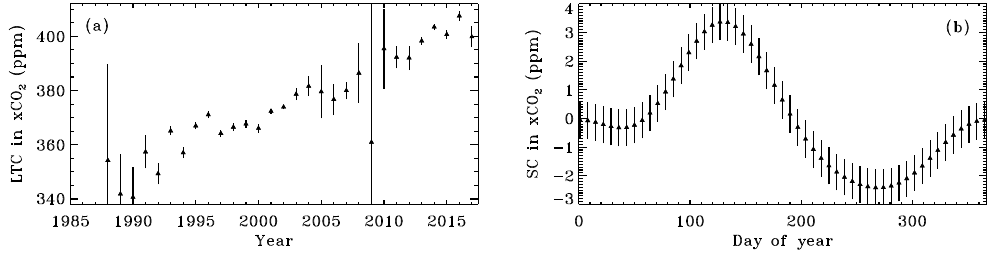
Figure 7. Decomposition of MkIV ground-based measurements of xCO 2 into a long-term secular trend (a) and a seasonal cycle (b) . Years with little data, or with inconsistent xCO 2 values, have large uncertainties. The seasonal cycle has its peak around day 130 and its maximum rate of decrease around day